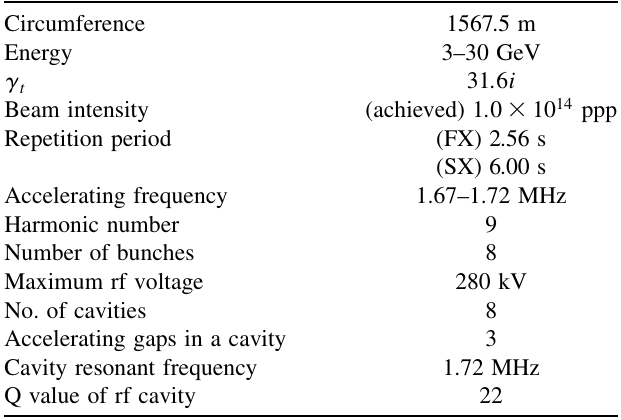
TABLE I. Parameters of the J-PARC MR and its rf